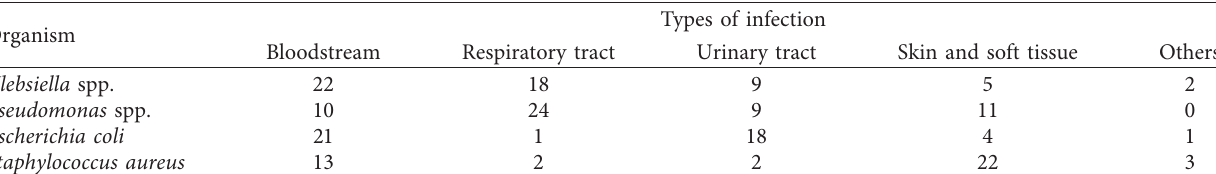
Table 2: Types of infections caused by various organisms.